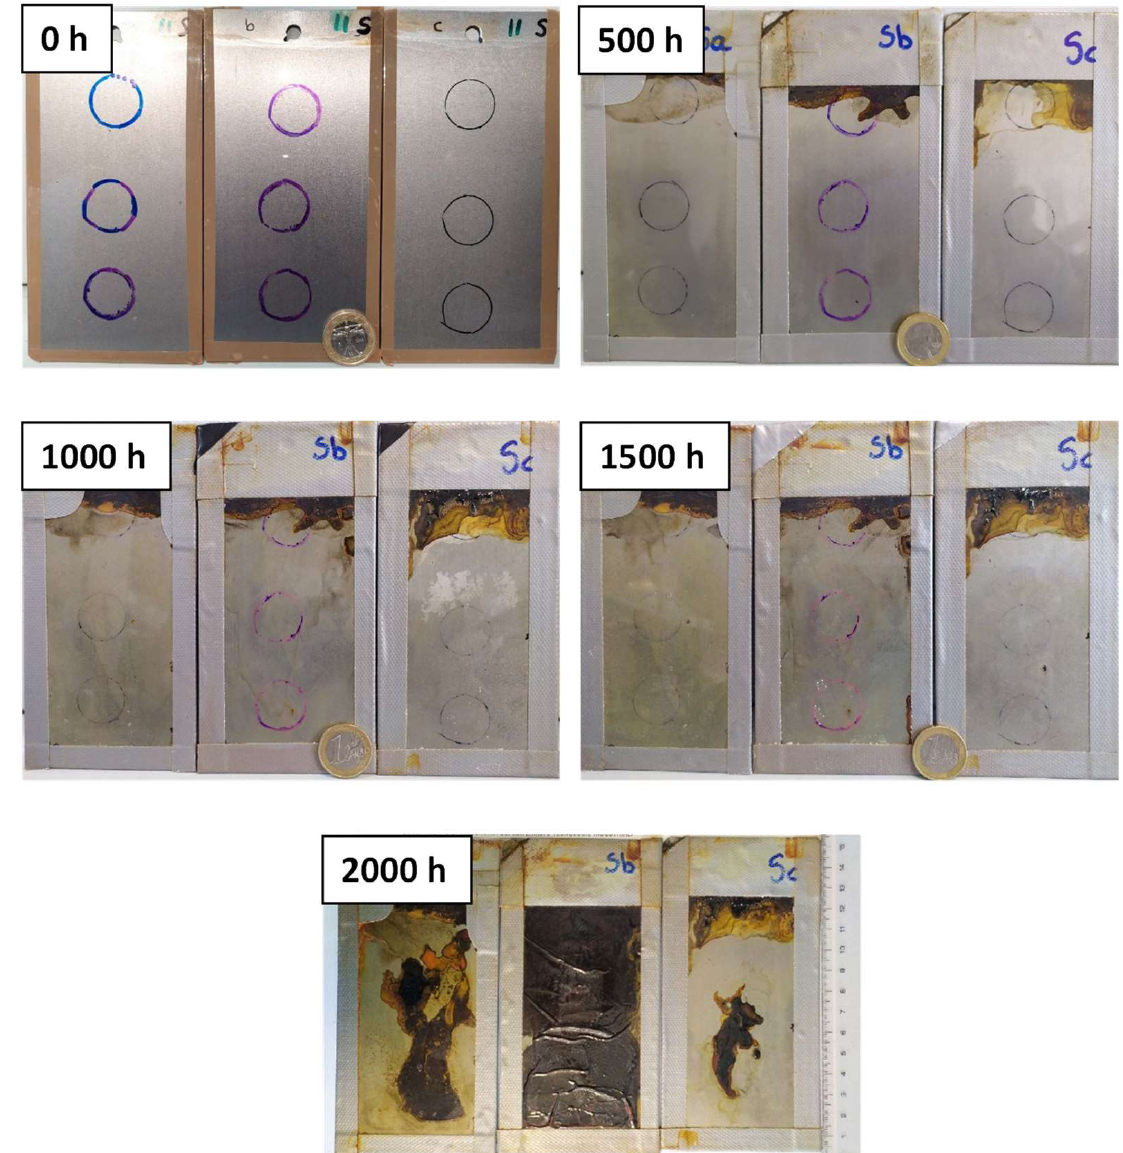
Figure 4. State of damage of painted steel samples after 0, 500, 1000, 1500, and 2000 h of NSST.